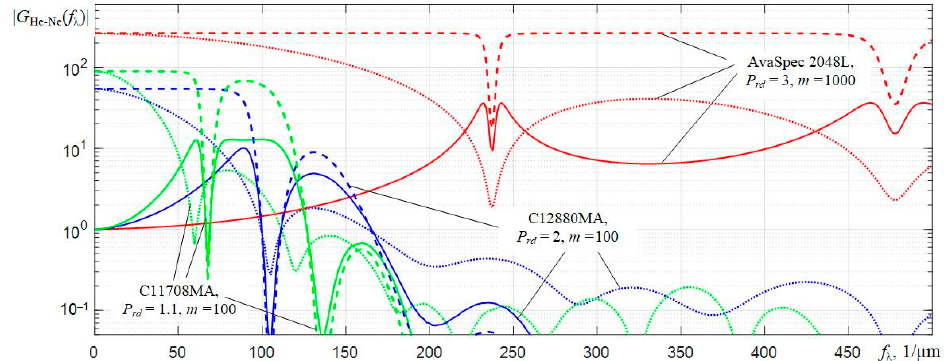
Figure 8. Moduli of the components of the Fourier transforms | G He-Ne ( f λ )| of the original He-Ne laser spectra (dotted lines) obtained for three spectrometers, the moduli of the formed normalized transfer functions of the Wiener filter | H Wn He-Ne ( f λ )| (solid lines) and the results of their multiplication (dashed lines) in the frequency range from 0 to 500 1/ μ m. Therefore, when the inverse Fourier transform (3) is applied to this product, the shape of the corrected spectra ( ) r S ∗ λ is formed not as a δ -function (its Fourier transform has a uniform spectrum), but as a central response with the presence of lateral oscillations, which is illustrated by the dependencies in Figure 9. In a hypothetical case, i.e., in the absence of radiation noise and spectrometer noise, the corrected spectra of the He-Ne laser ( ) ∗ λ will have the form of a δ -function. r S